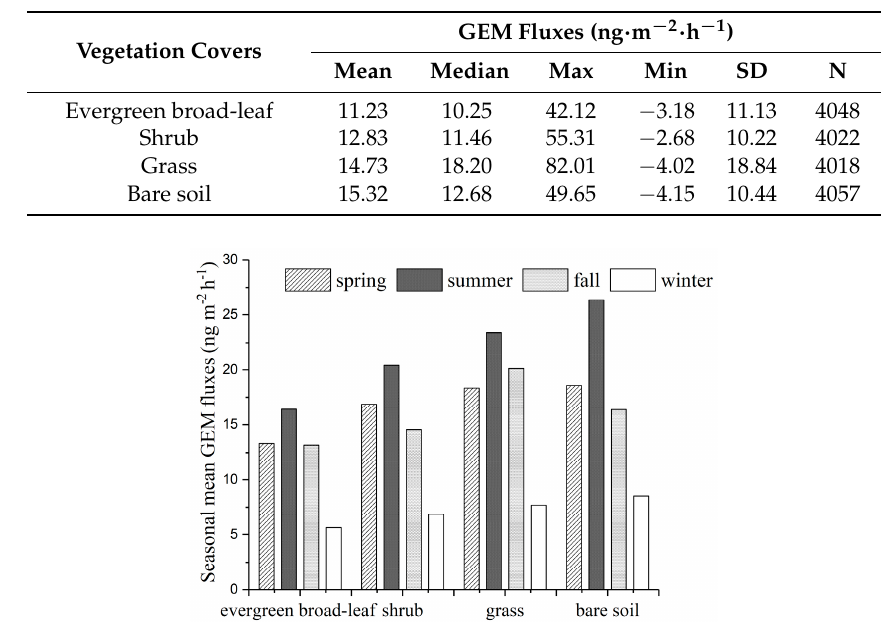
Figure 1. Seasonal variation of GEM fluxes at the soil–air interface of the four vegetation covers.